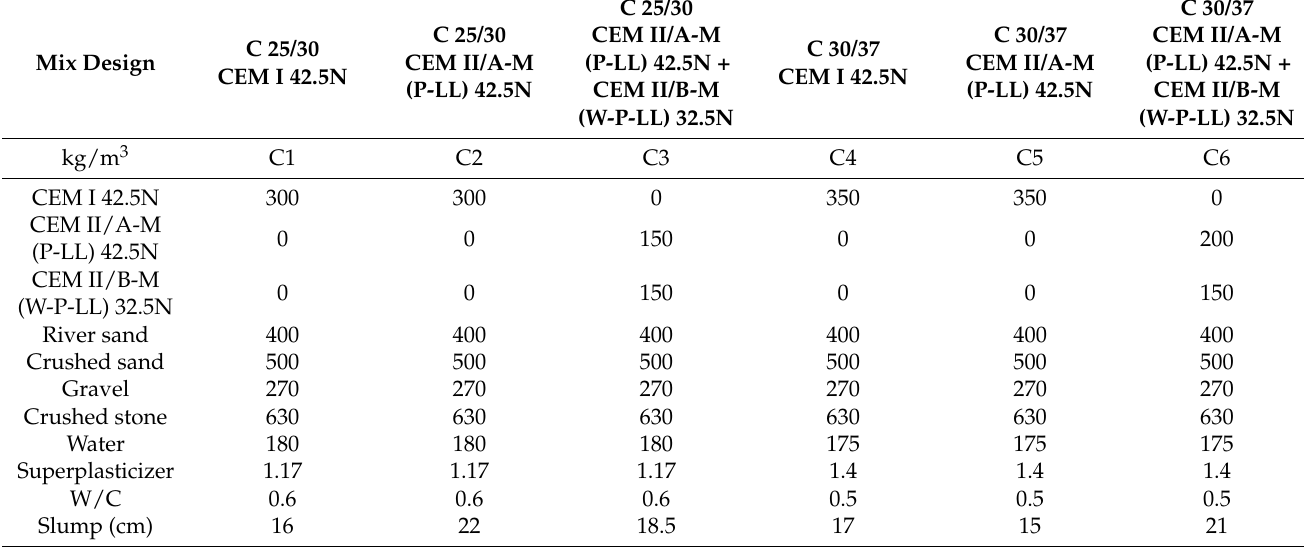
Table 4. Mix design and characteristics of C25/30 and 30/37 strength classes